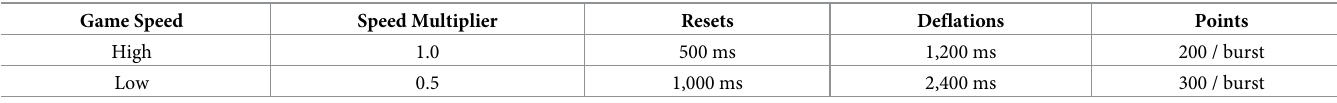
Table 1. Description of the two game speeds: High and low speeds.